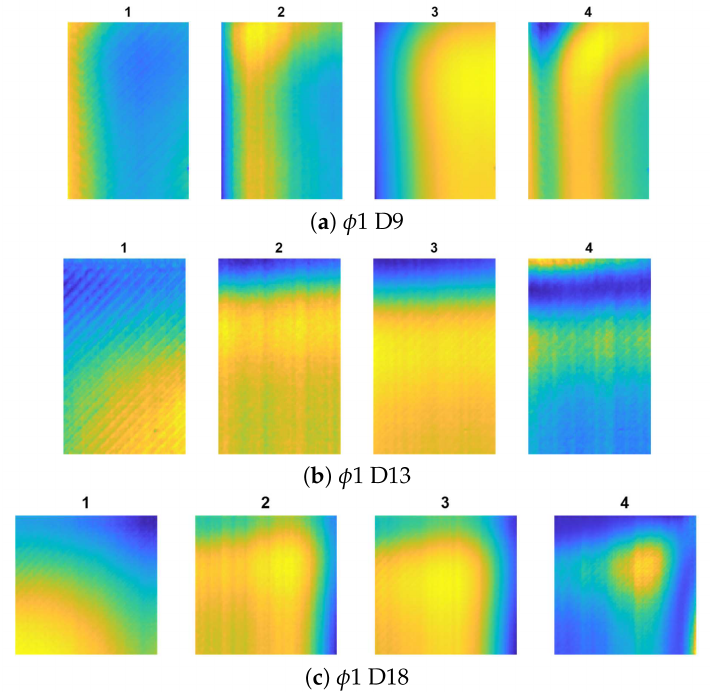
Figure 7. The results of defect visualisation for defects φ 1 and different D values: 1—raw thermogram (captured after the heating phase t = 60 s), 2—chosen result from sequence A I , 3—chosen result from sequence A D , and 4—chosen result from sequence A Res .